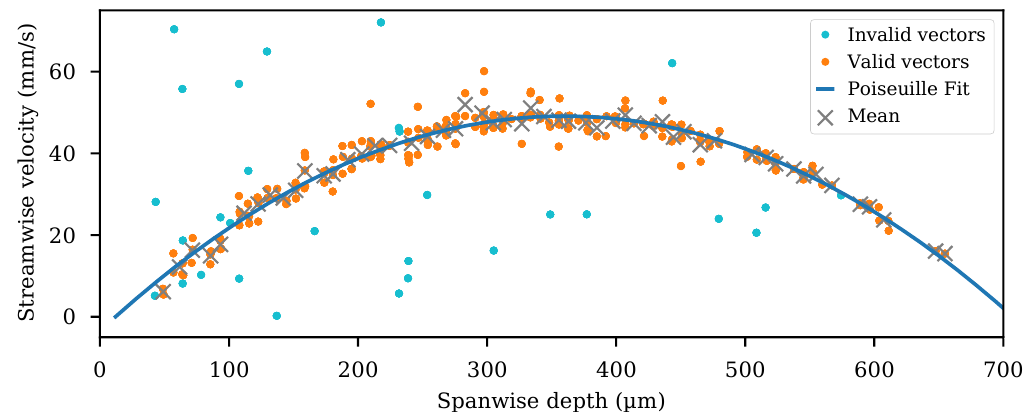
Figure 5. Valid and invalid flow velocity vectors shown spanwise across the microfluidic channel, for a single streamwise bin. The mean value of the valid vectors in each spanwise bin is shown. A parabolic Poiseuille fit to the valid vectors is shown. The top of the microfluidic channel as shown in Figure 2 appears at a 0µm spanwise